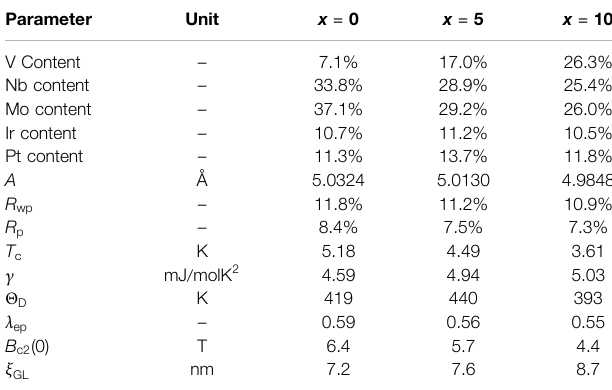
TABLE 1 | Structural and physical parameters of the V 5+2 x Nb 35 − x Mo 35 − x Ir 10 Pt 15 HEAs.